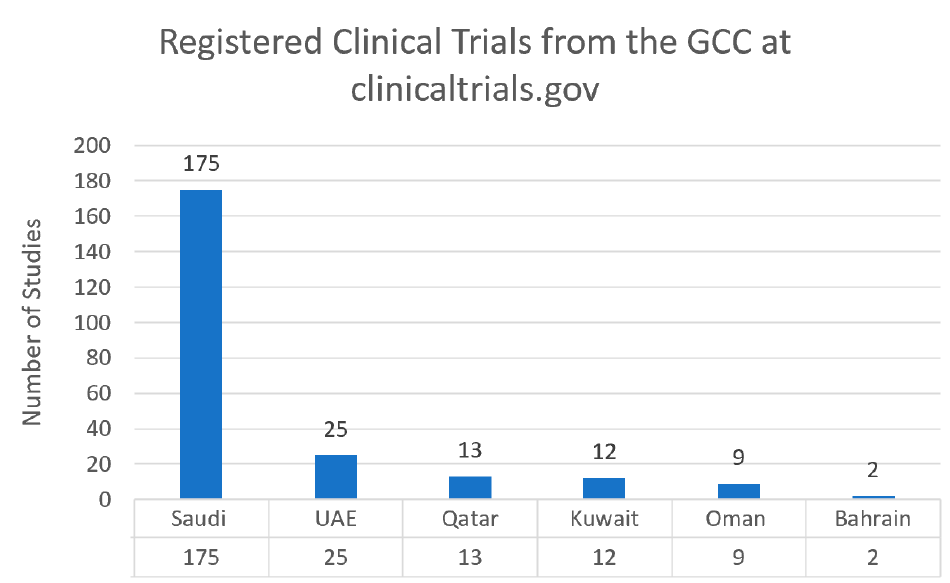
Figure 1. Registered clinical trials from the GCC countries at clinicaltrials.gov as of 21 October 2022.